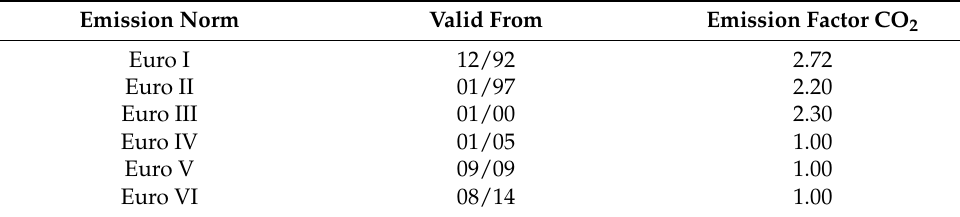
Table 2. Emission values for vehicles with petrol engine. Emission